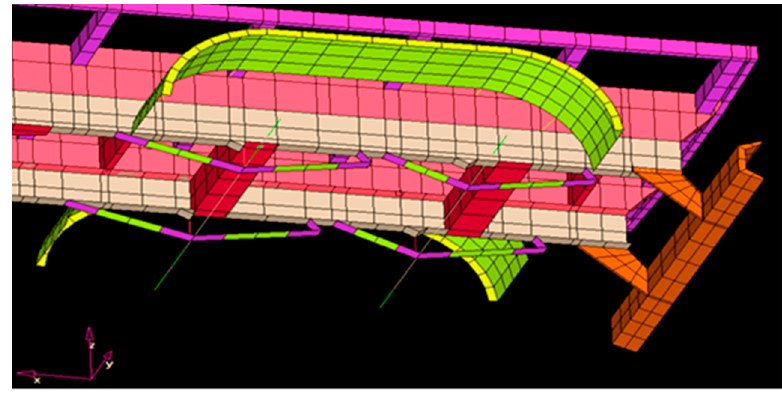
Figure 9. Detail of the rear suspension system.